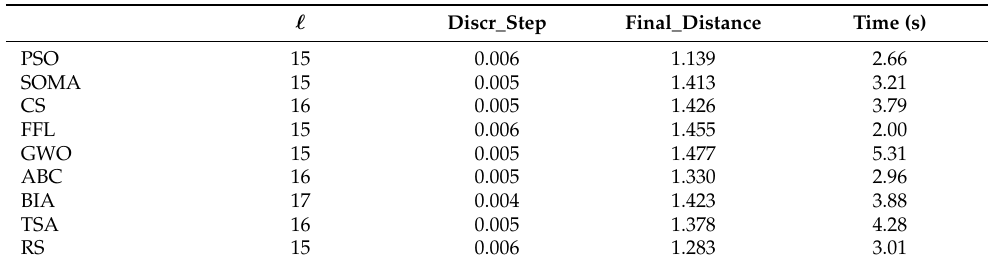
Table 10. The mean results for Function f 1 for 50 runs of evolutionary algorithms with a value of maxFES = 2500.